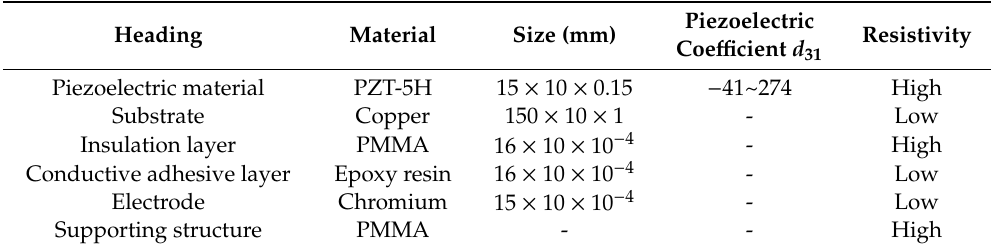
Figure 2. The symmetrical ring-shaped piezoelectric energy harvester (SR-PEH). Table 1. Structural sizes and physical parameters.